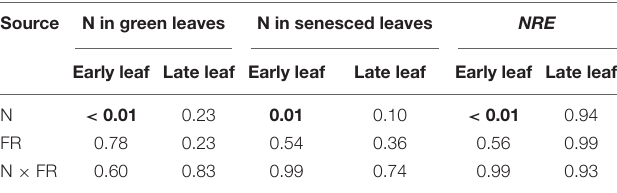
N, nitrogen addition (n = 17); FR, sink decrease by flower removal (n = 6); NRE, N resorption efficiency.EL and LL represent early and late leaves, respectively. Significant effects (P < 0.01 level) are